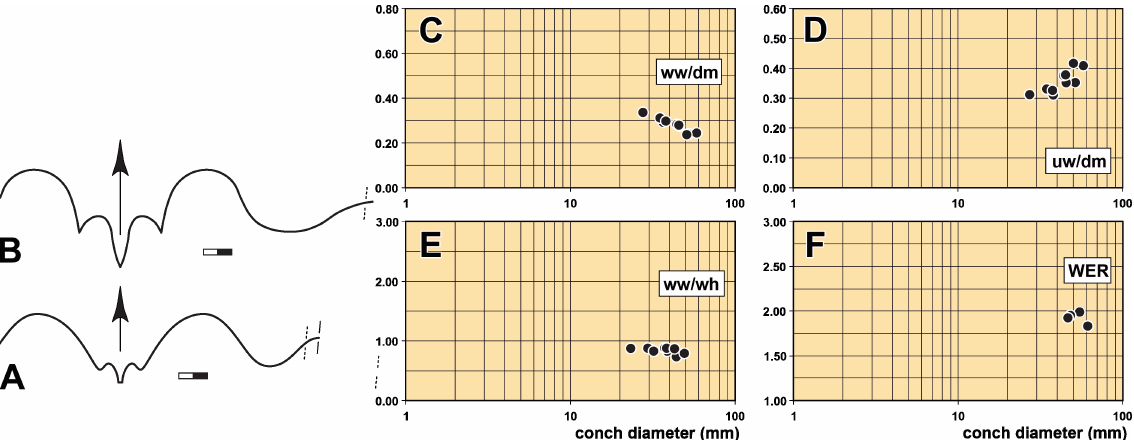
Fig. 6. Pseudoprobeloceras pernai (Wedekind, 1918). A . Suture line of specimen MB.C.30417.1 (Etzold 1910 Coll.) from Oberscheld (“Tiefe Grube”), at dm = 27.0 mm, ww = 9.0 mm, wh = 11.0 mm. B . Suture line of specimen MB.C.30418, probably from Oberscheld, at dm = 48.3 mm, ww = 11.9 mm, wh = 15.6 mm. C–F . Ontogenetic trajectories of the cardinal conch parameters. Scale bar units = 1 mm.